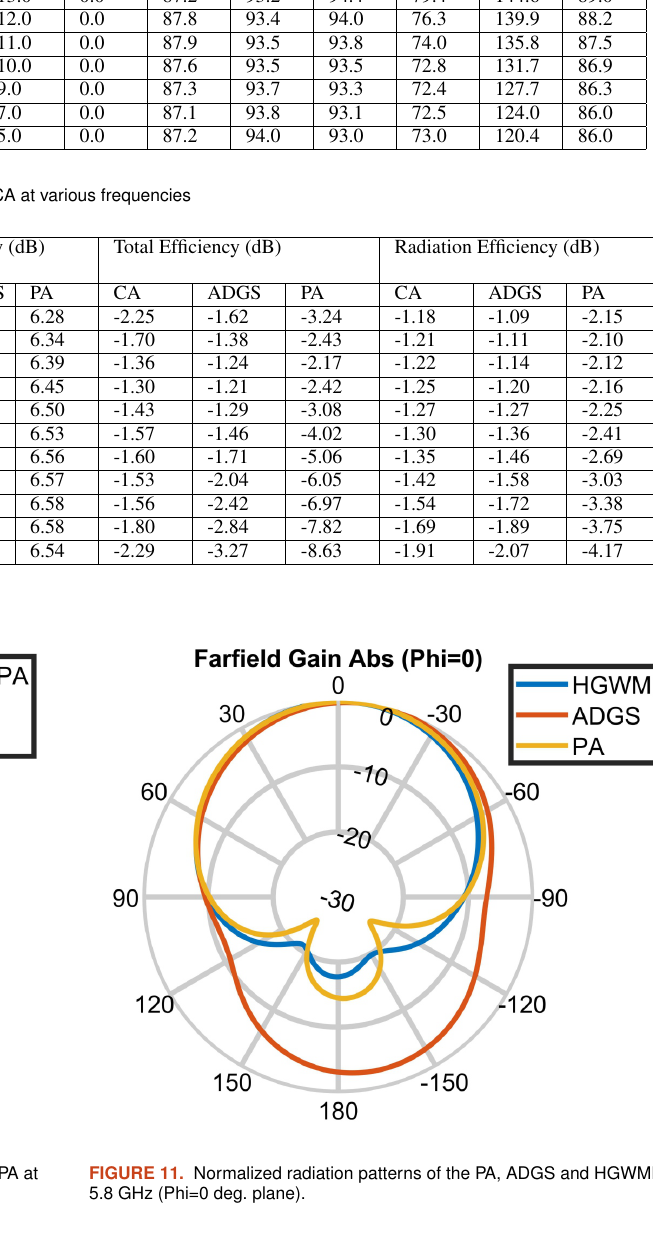
× 23.45 mm. The HGWMPA is fabricated and measured. The simulated and measured results show good agreement. The antenna parameters confirm that the proposed compact HGWMPA is suitable for sub-6 GHz 5G